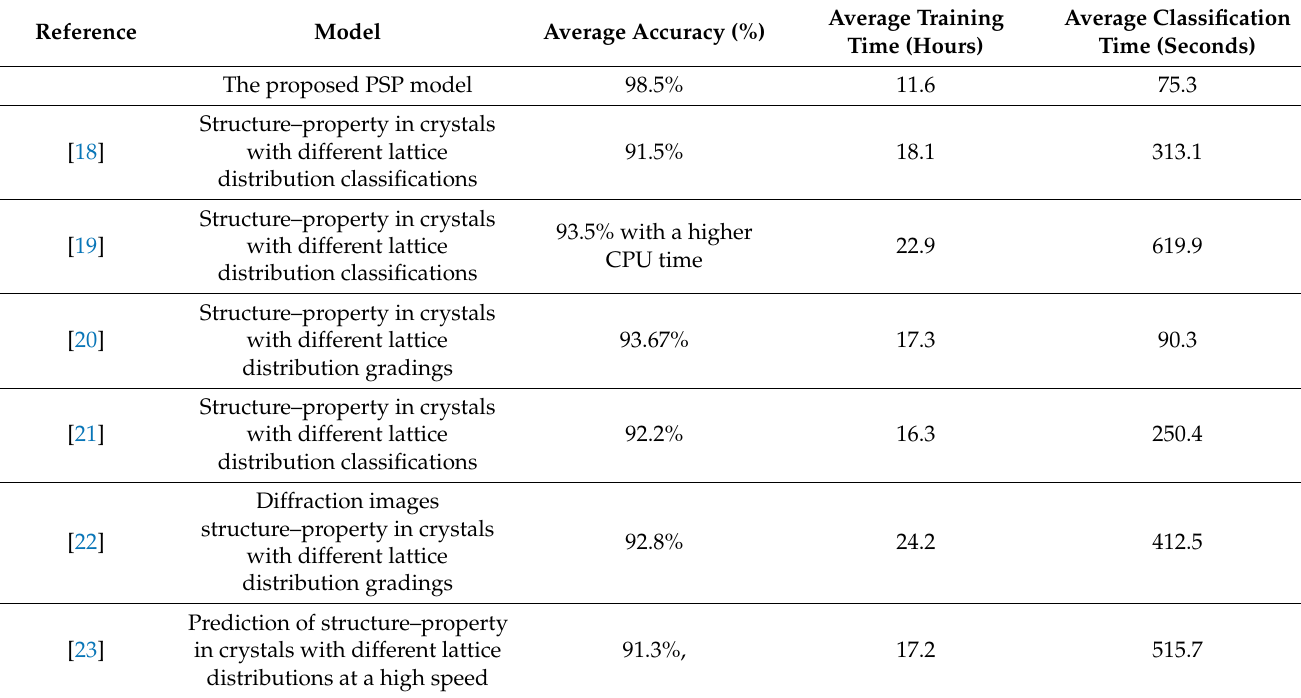
Table 8. Performance comparison of the proposed model versus state-of-the-art